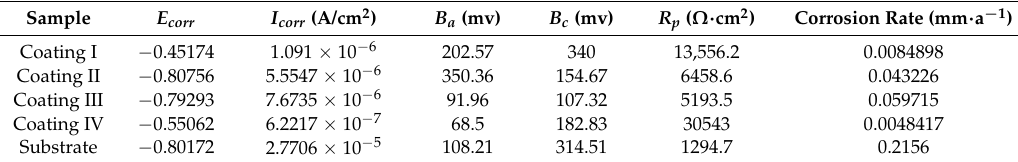
Table 3. Electrochemical data of substrate and coatings with different